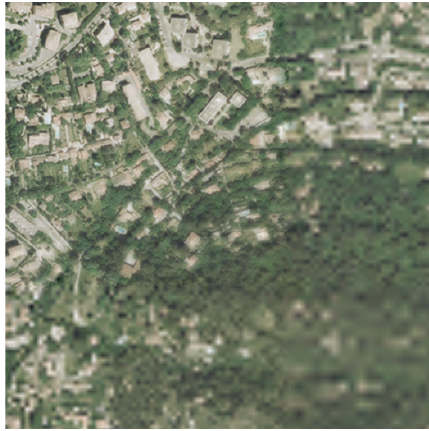
Figure 11: Application of method II to the example: l h = 0, l m = 2, l l =